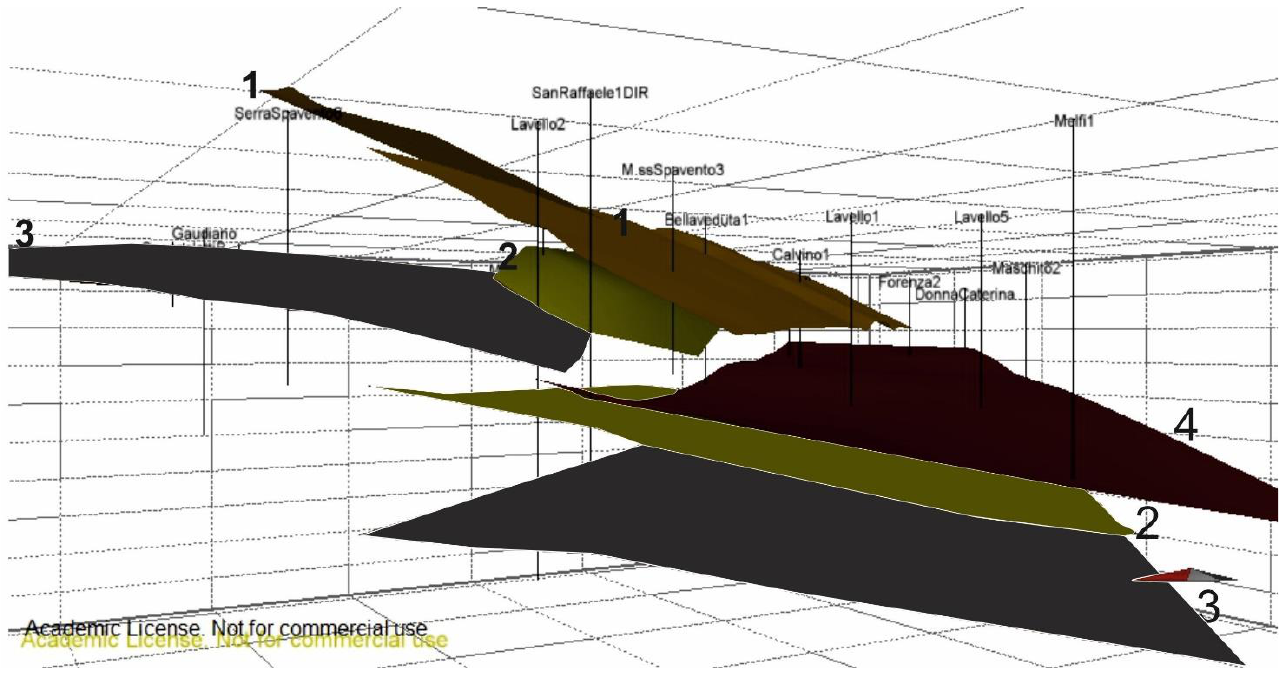
Figure 4. Marker surfaces reconstructed in hanging wall and footwall blocks offset by an NW–SE trending fault. The markers are numbered as follows: 1: Top Pliocene, 2: Top Eocene, 3: Top Cretaceous, 4: Top Miocene.